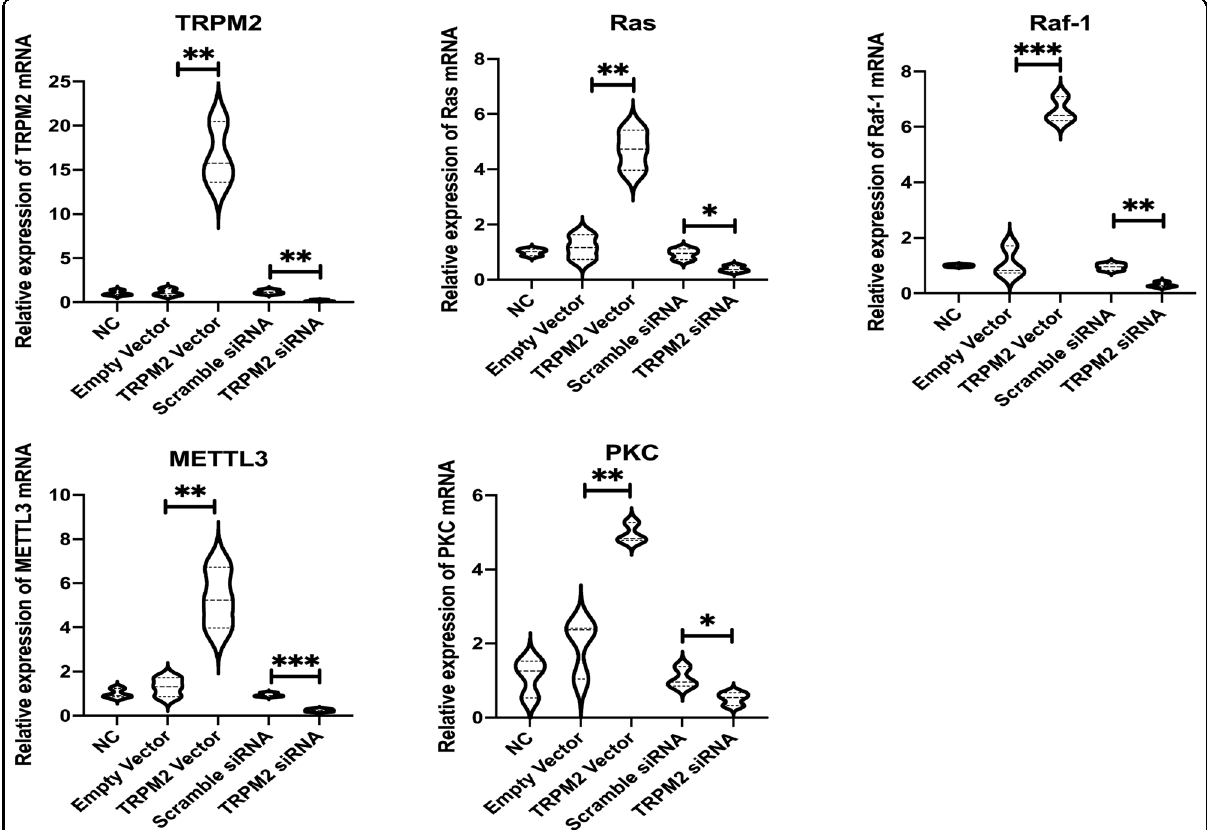
Fig. 6 Expression of MAPK/MEK pathway key molecules in BxPC-3 stable transfection groups. NC, normal control; Empty Vector, BxPC-3 without any plasmid transfection; TRPM2 vector, TRPM2 overexpression group; scramble siRNA, BxPC-3 cells with scramble sequence of small interfering RNA transfection group; TRPM2 siRNA, BxPC-3 cells with TRPM2 small interfering RNA transfection group. ** P < 0.01, *** P < 0.001, three repeats in each